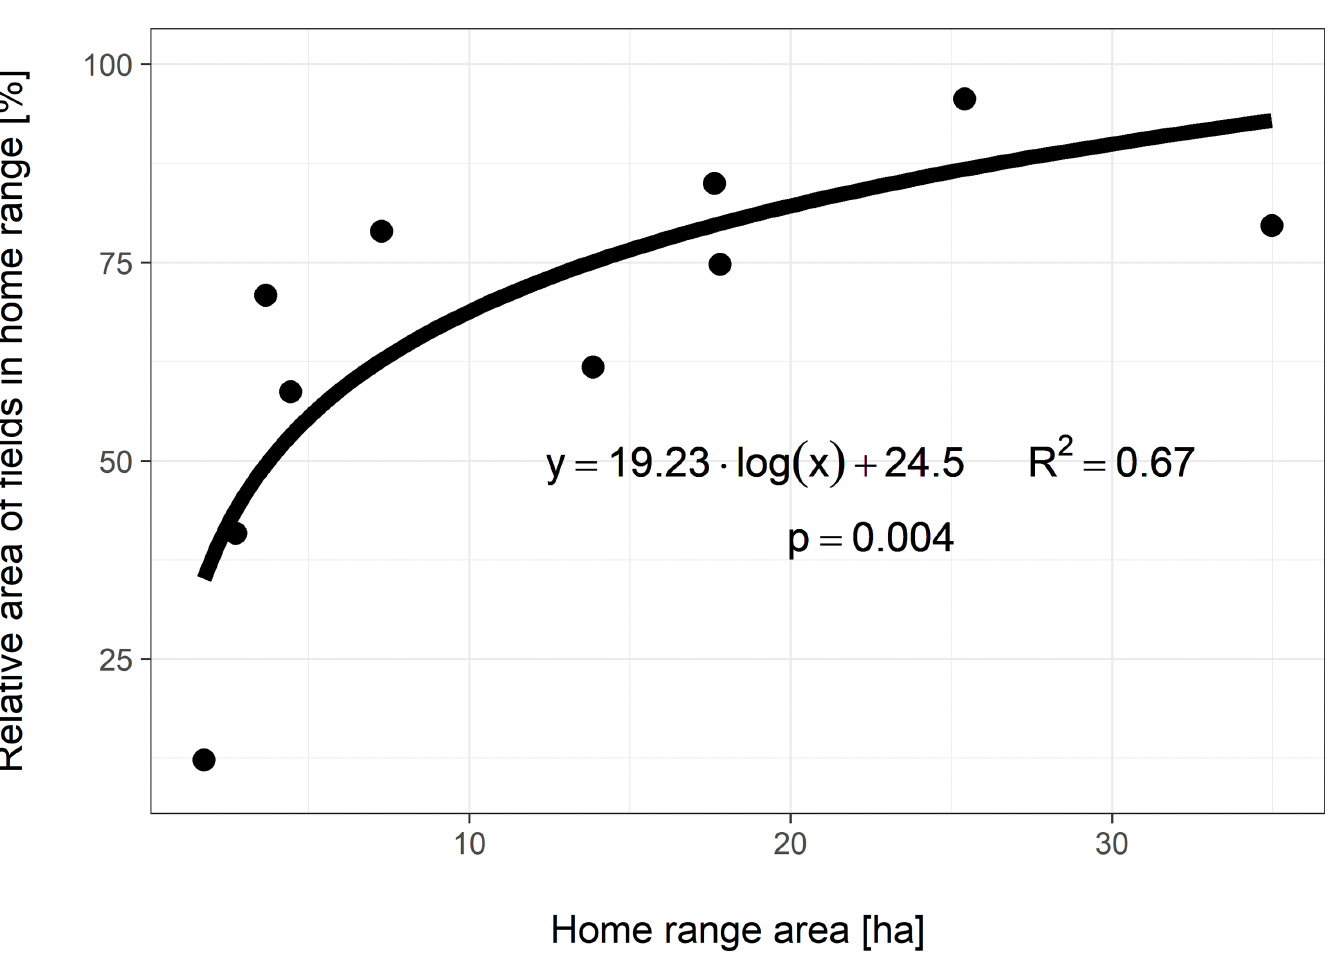
Fig 4. Agricultural field area percentage relative to inactive home range size. Bold line depicts regression function described in the plot. P -values for logarithmic regression assume a null hypothesis based on parameter a of the regression equation y = a (cid:3) log ( x )+ b is equal to zero. Natural logarithm was used for regression